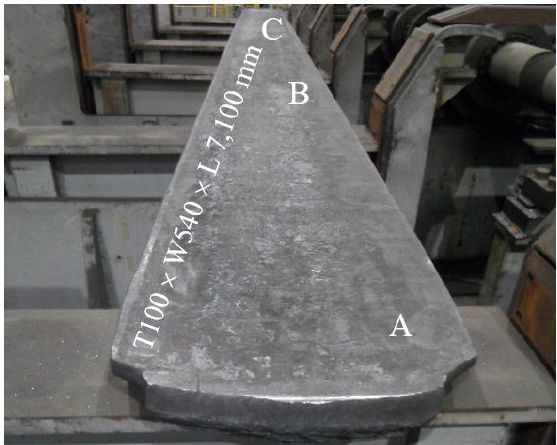
Figure 1. Appearance and dimensions of the as-rolled lightweight steel; A, B, and C represented the locations where the microstructural samples were taken form the as-rolled